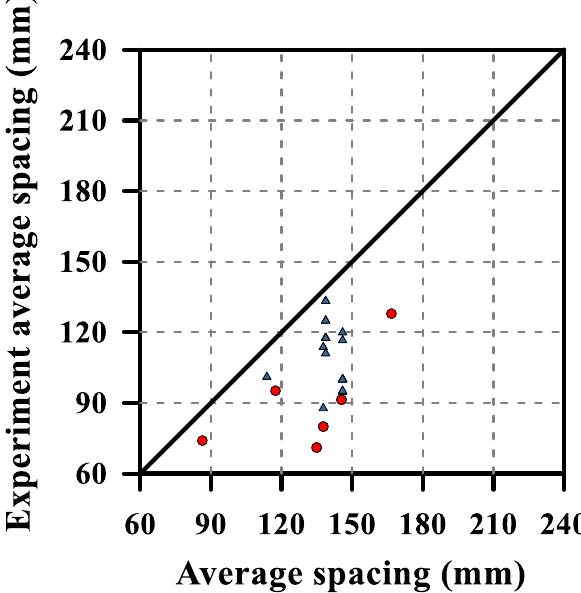
Fig. 16 Average flexural crack spacing calculated using Eq. (6) (Circle points are the specimens in this work; triangle points are the specimens in the references (Chiu et al. 2014,